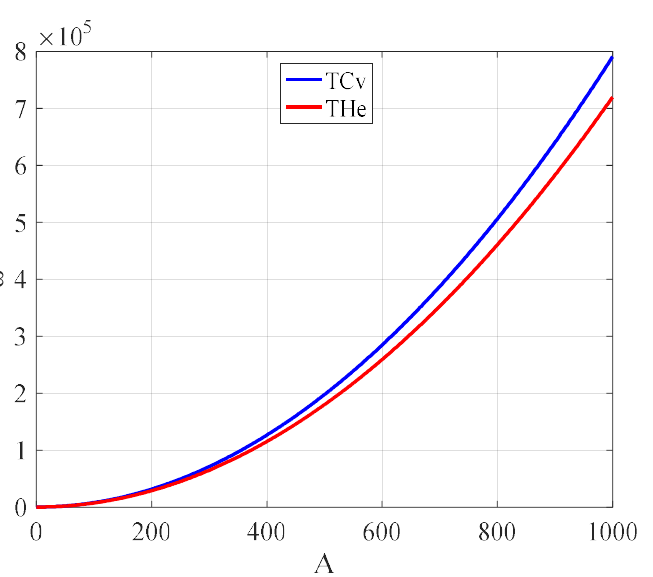
Figure 3. The angular velocity for the case of Equation (43) when using the Cveticanin approach (blue curve) [30] and He’s approach (red curve) [13].